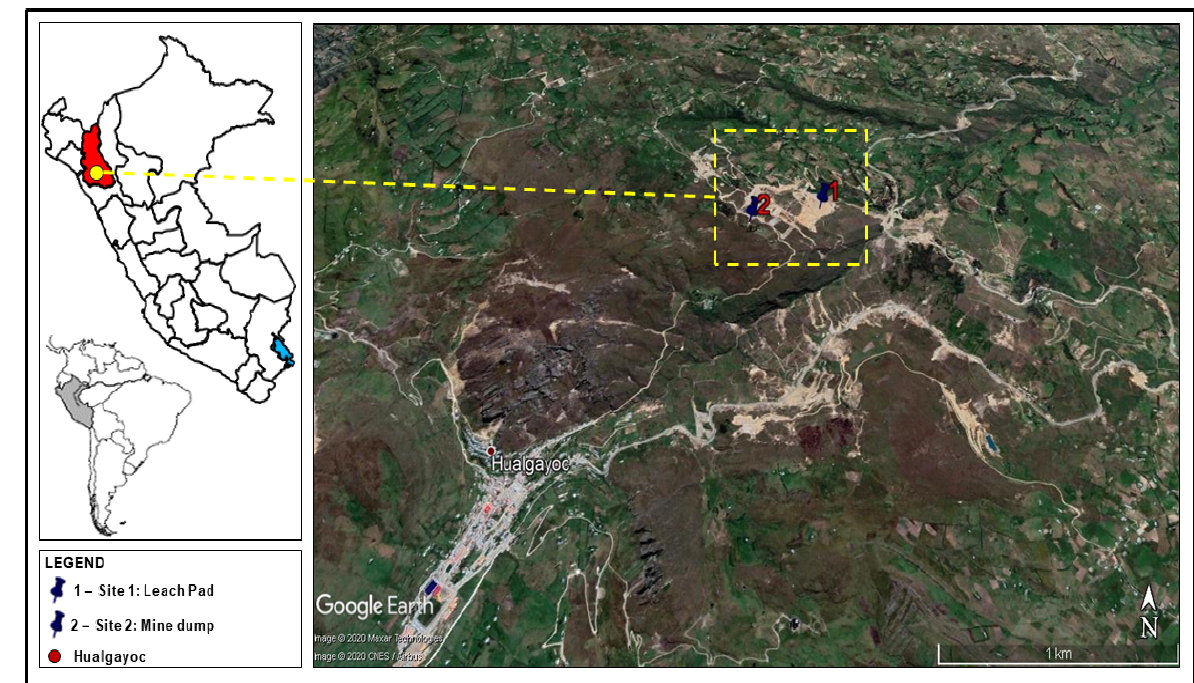
Figure 1. Localization of the mining environmental liabilities (site #1—leach pad, site #2—mine dump) of the ex-mining unit Los Negros in Hualgayoc district, Cajamarca region, Peru.